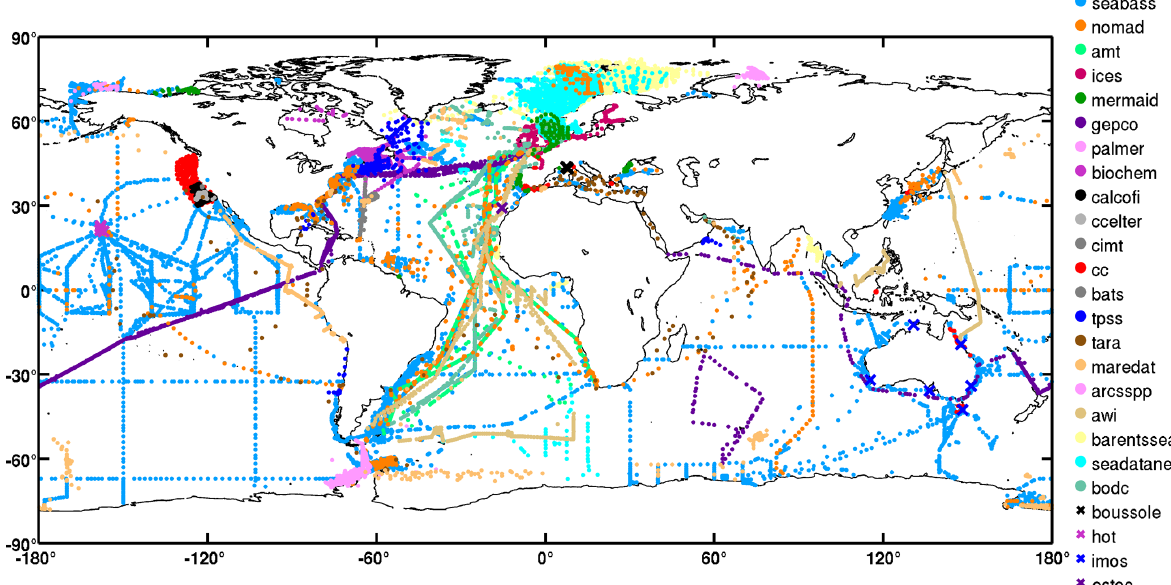
Figure 9. Global distribution of chlorophyll a concentration per dataset in the final table. All chlorophyll data were considered, but for a given station, HPLC data were selected if available. Crosses show sites from where data of chlorophyll are available in a specific geographic